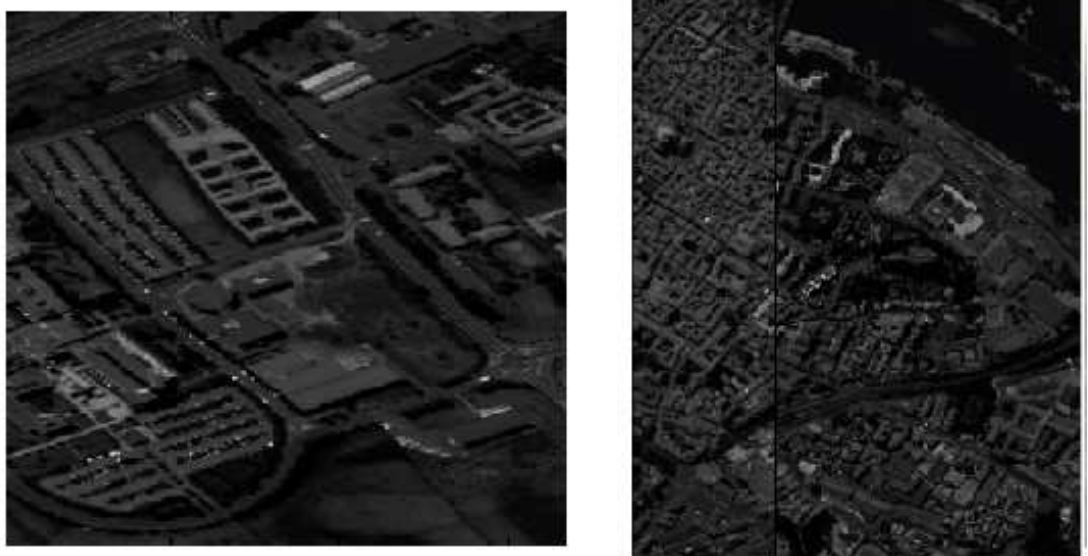
Figure 4. The datasets used for experiments. The image on the left is PaviaU (University), while the image on the right is PaviaC (City